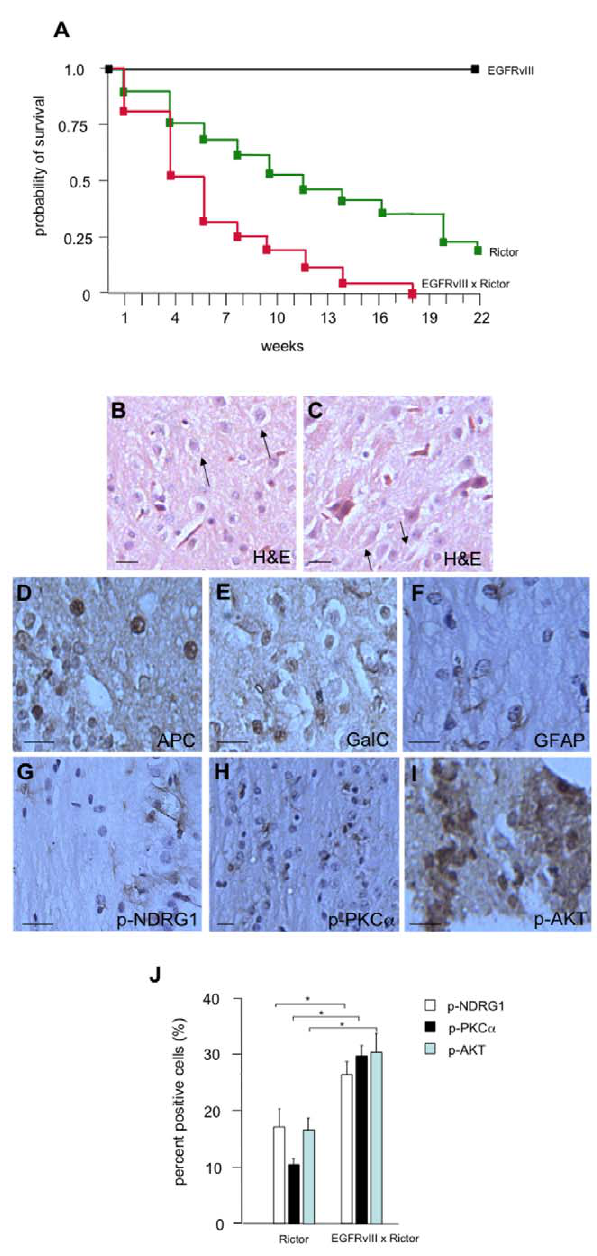
Figure 4. Transgenic GFAP-EGFRvIII;GFAP-Cre/Rictor loxP/loxP mice exhibit reduced survival, enhanced tumor grade and mTORC2 signaling. In (A), wild-type mice had 100% tumor-free survival in these experiments (not shown), as did GFAP-EGFRvIII transgenic mice. Twenty-six transgene-positive mice were followed for twenty-two weeks (EGFRvIII). Twenty-nine transgene-positive GFAP-Cre/Rictor loxP/loxP mice were followed for twenty-two weeks (Rictor). Transgene-positive GFAP-EGFRvIII and GFAP-Cre/Rictor loxP/loxP mice were crossed and a cohort of twenty-four animals were followed for eighteen weeks (EGFRvIII x Rictor). (B&C) Increased grade of oligodendroglioma in GFAP-EGFRvIII; GFAP-Cre/Rictor loxP/loxP mice. H & E sections of a typical tumor displayed increased regions of necrosis and cells with pyknotic nuclei. Increased endothelial proliferation was also observed consistent with anaplastic oligodendroglioma in humans (grade 3 WHO). (D–F) APC, GalC and GFAP immunoreactive cells from representative oligodendroglial tumors. (G–I) mTORC2 markers displayed elevated immunohistochem- ical staining in sections of gliomas from GFAP-EGFRvIII; GFAP-Cre/ Rictor loxP/loxP mice. In B–I, scale bar; 20 m m. (J) Quantification of